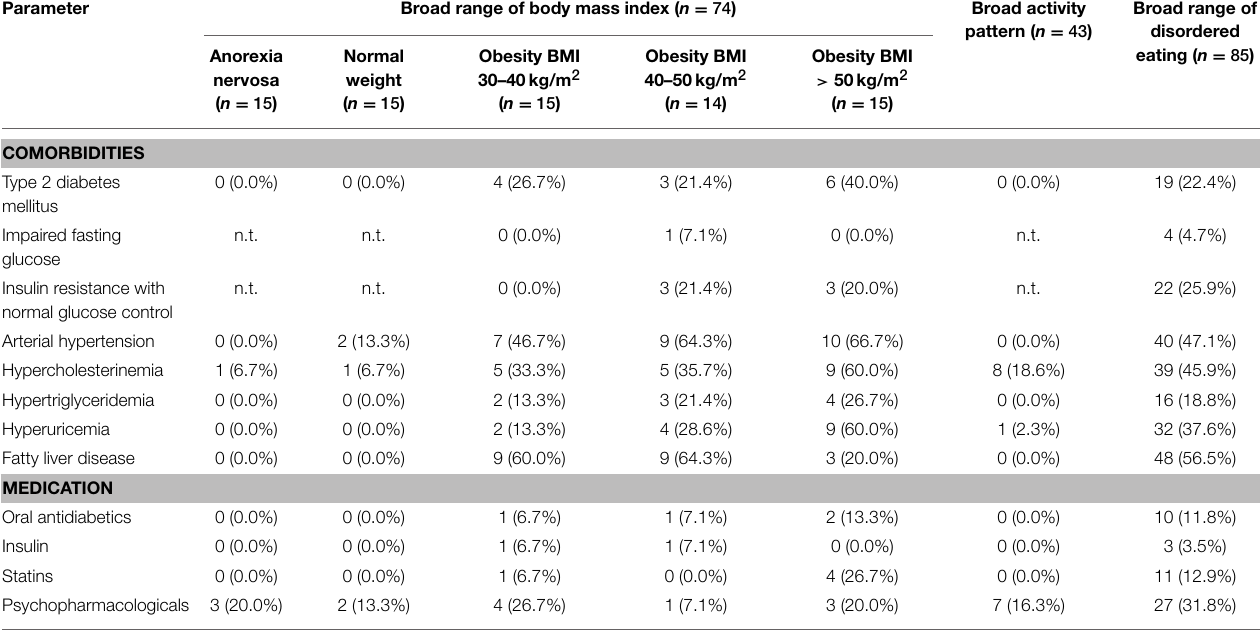
TABLE 2 | Comorbidities and medication of the three study populations (a, b, and c). Parameter Broad range of body mass index ( n = 74